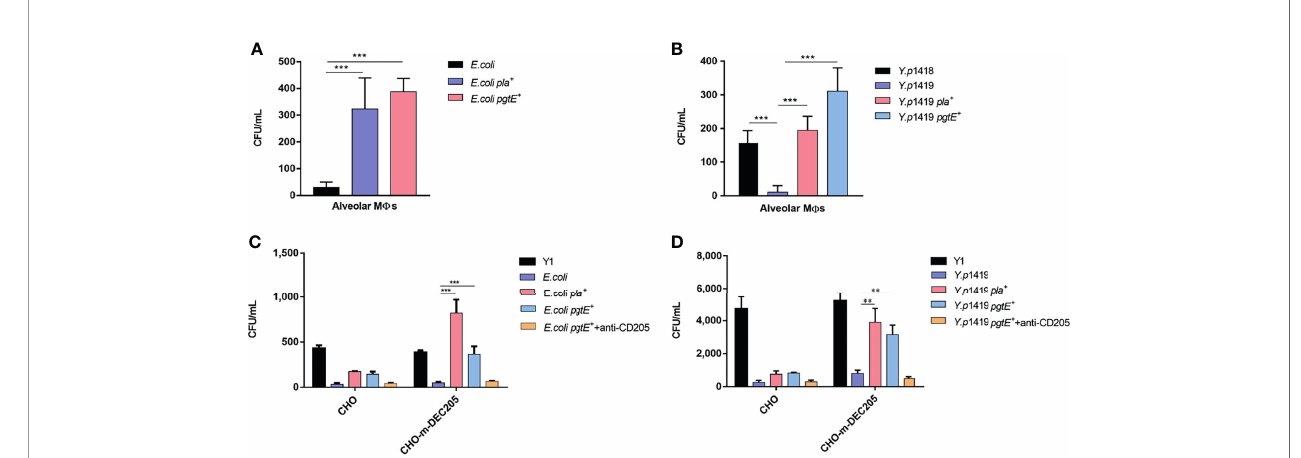
FIGURE 2 | PgtE-expressing E. coli and Y. pestis invade alveolar macrophages and invade CHO-m-DEC-205. (A) PgtE-expressing E. coli were examined for their ability to enter alveolar macrophages. The bacteria used were E. coli, E. coli pla + and E. coli pgtE+ . (B) PgtE-expressing Y. pestis were examined for their ability to enter alveolar macrophages. The bacteria used were Y.p 1418 , Y.p 1419 , Y.p 1419 pla + , Y.p 1419 pgtE + .The number of phagocytized bacteria was determined by evaluating the CFUs on the plates after two days. The data presented were collective from three independent experiments. *P < 0.05, **P < 0.01, ***P < 0.001. (C) PgtE-expressin g E. coli invade the CHO cell line expressing CD205. Epithelial CHO cells expressing or not expressing CD205 (CHO and CD205, respectively) were infected with PgtE- and Pla-expressing E. coli . Y. pseudotuberculosis (Y1); E. coli, E. coli pla + , and E. coli pgtE + were examined for their abilities to invade CHO/ CHO-m-DEC-205 cells during a gentamicin protection assay, in presence or absence of anti-DEC-205 (5 m g/ml). The numbers of phagocytosed bacteria were determined by counting the bacterial CFUs on the plates the next day. The data presented were pooled from three independent experiments. *P < 0.05, **P < 0.01, ***P < 0.001. (D) PgtE-expressin g Y. pestis invades the CHO cell line expressing CD205. Epithelial CHO cells expressing or not expressing CD205 (CHO and CD205, respectively) were infected with PgtE- and Pla-expressing Y. pestis . Y. pseudotuberculosis (Y1), Y.p 1419 , Y.p 1419 pla + and Y.p 1419 pgtE + were examined for their abilities to invade CHO/CHO-m-DEC-205 cells during a gentamicin protection assay, in presence or absence of anti-DEC-205 (5 m g/ml). The numbers of phagocytosed bacteria were determined by counting the bacterial CFUs on the plates after two days. The data presented were pooled from three independent experiments. *P < 0.05, **P < 0.01, ***P <